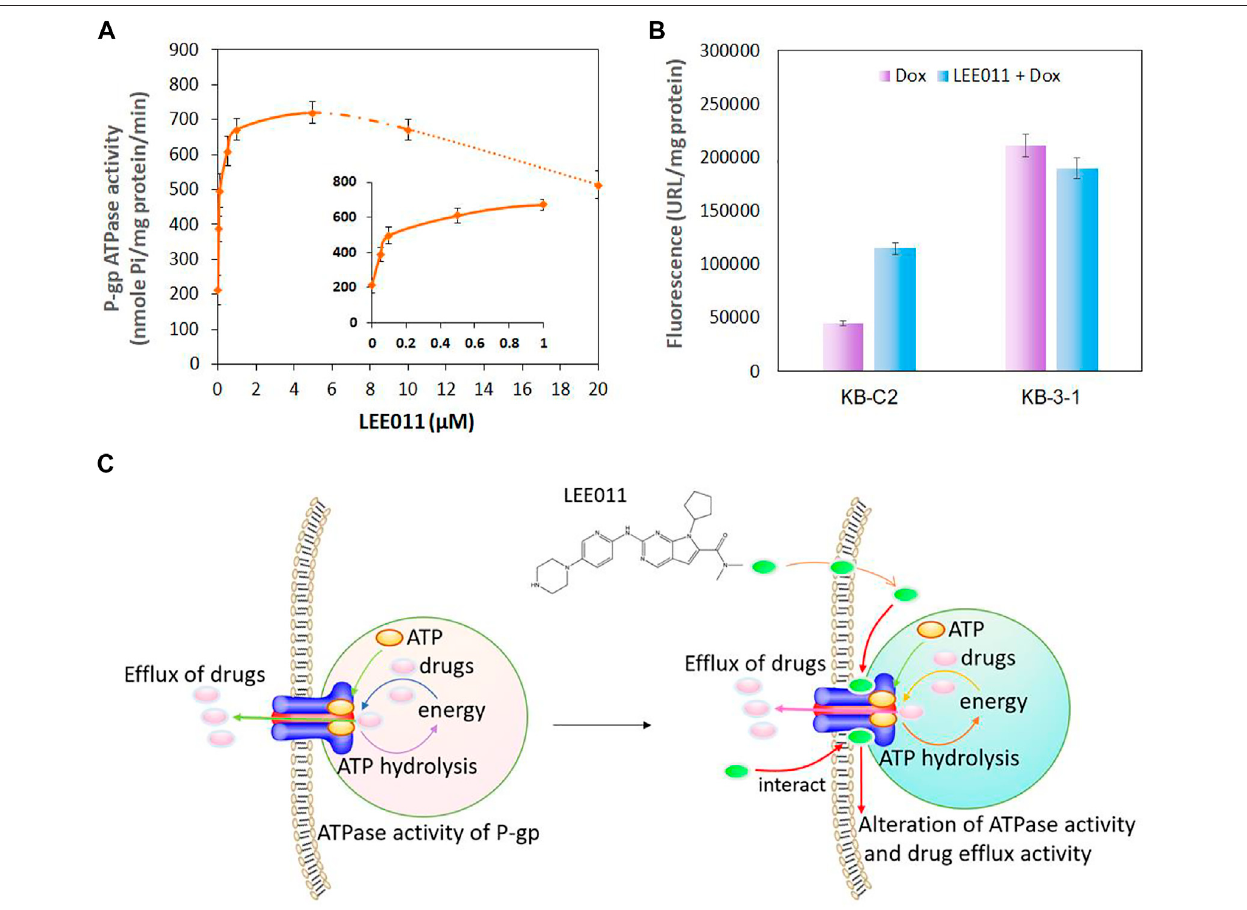
FIGURE5| TheinteractionbetweenribociclibandtheP-gptransporteralterstheATPaseactivityofP-gpanddrugef fl uxactivityinKB-C2cells. (A) ATPaseactivity of P-gp following incubation with ribociclib. (B) A comparison ofthe drug accumulation in MDR KB-C2 cells over-expressing P-gp and the drug sensitive KB-3-1 cells in thepresenceorabsenceofribociclib.Thecellswereco-culturedwithribociclib(9 µM)andDox(0.2 µM)for2 h.ThelevelofDox fl uorescencewasmeasured at550 nm. (C) A Scheme showing that ribociclib alters ATPase activity and drug ef fl ux by interacting with the P-gp transporter.